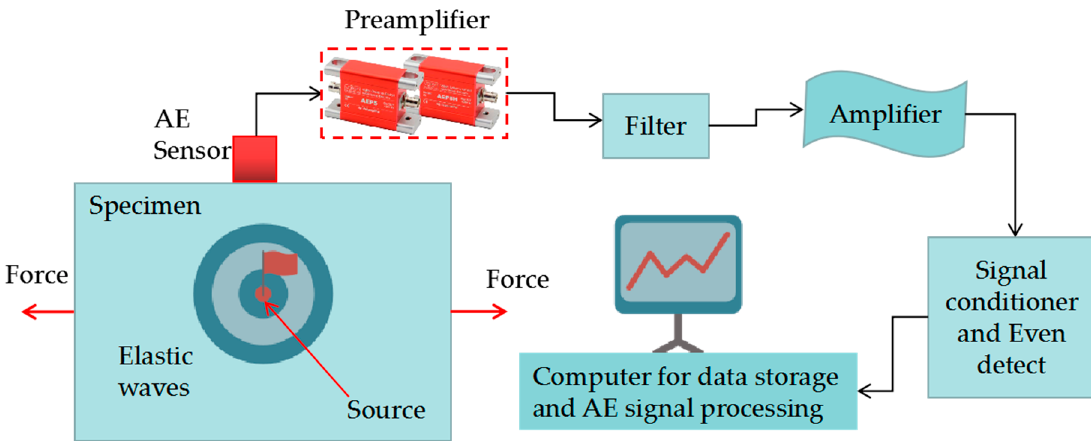
Figure 5. Acoustic emission (AE) method.